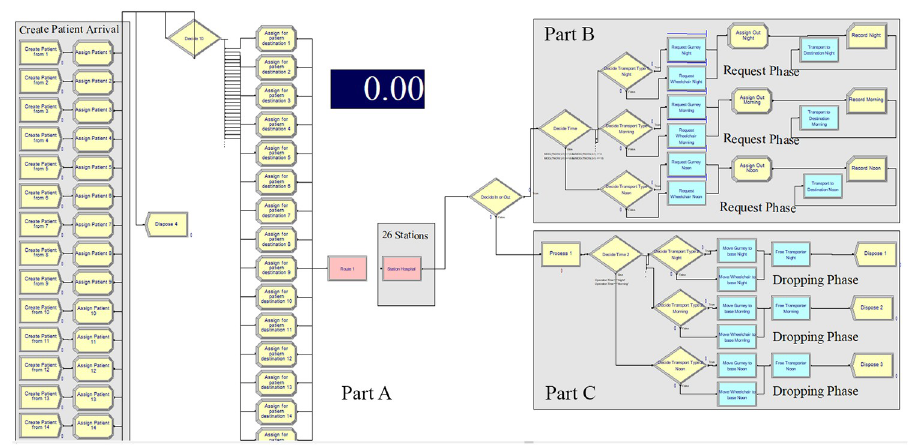
Fig 3. Structure of the simulation model for the intra-hospital patient transfer.